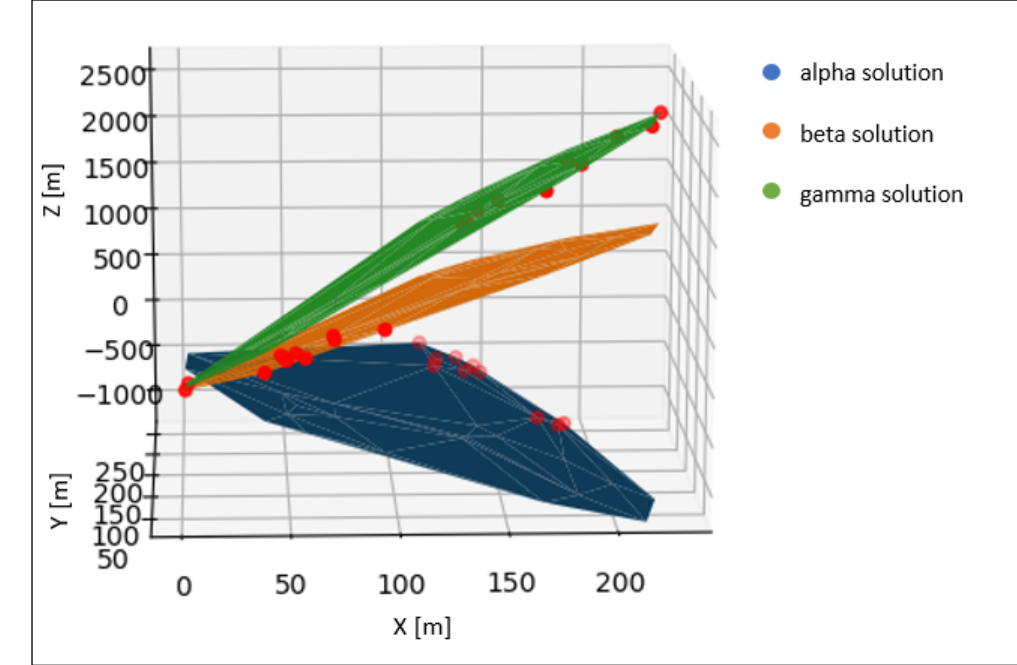
Figure 16. Test object—Msplit (q) fitting.